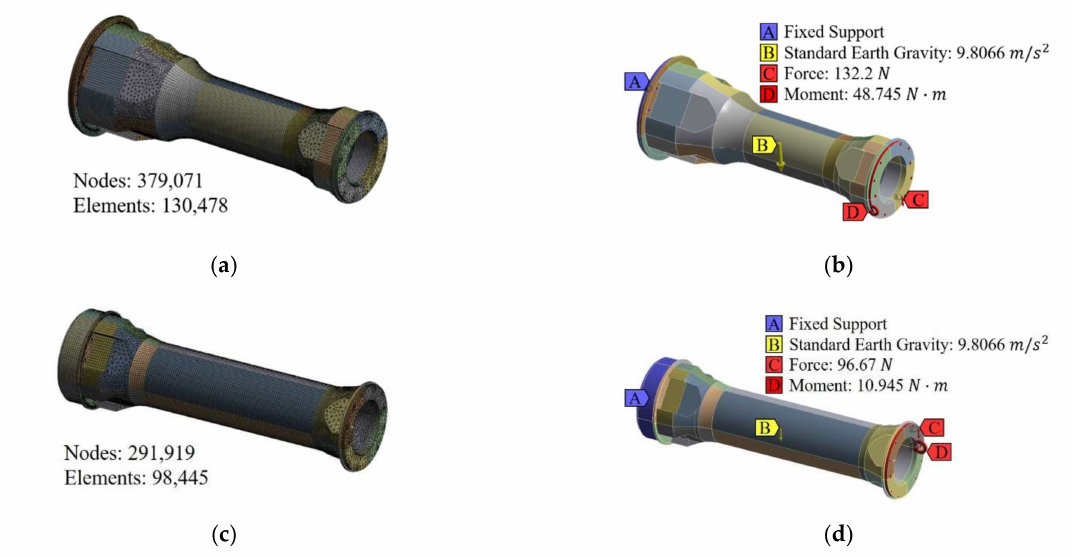
Figure 2. Meshes and load conditions for the FEA model of each link: ( a ) Upper link mesh; ( b ) upper link load conditions; ( c ) lower link mesh; and ( d ) lower link load